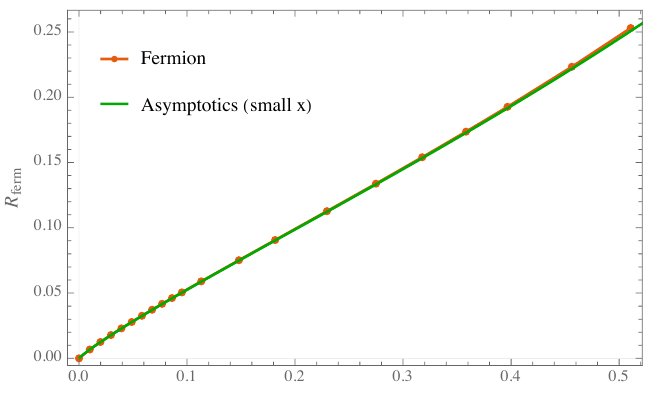
Figure 4 . The reflected entropy for the analytical prediction (3.4) versus the numerics. Numerical fitting of the data points with x < 0 . 1 to S R = − αφ ln φ + βφ gives { α, β } = { 0 . 149 , 0 . 563 } , agreeing well with the expression we obtained in (3.6) and